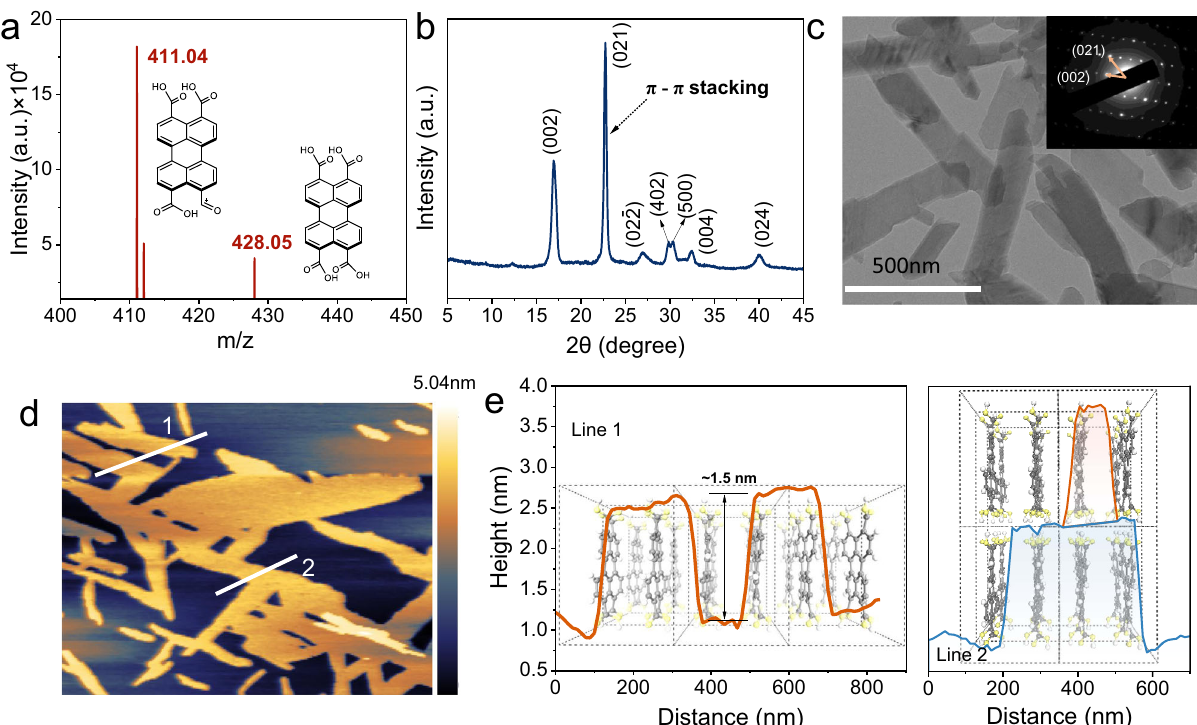
Fig. 1 Structural characterization of PTA nanosheets. a Time-of- fl ight secondary ion mass spectrometry (TOF-SIMS), b X-ray diffraction (XRD), c transmission electron microscope (TEM), inset: electron diffraction pattern, d atomic force microscope (AFM) image, and e corresponding height and simulated structure of PTA nanosheets.